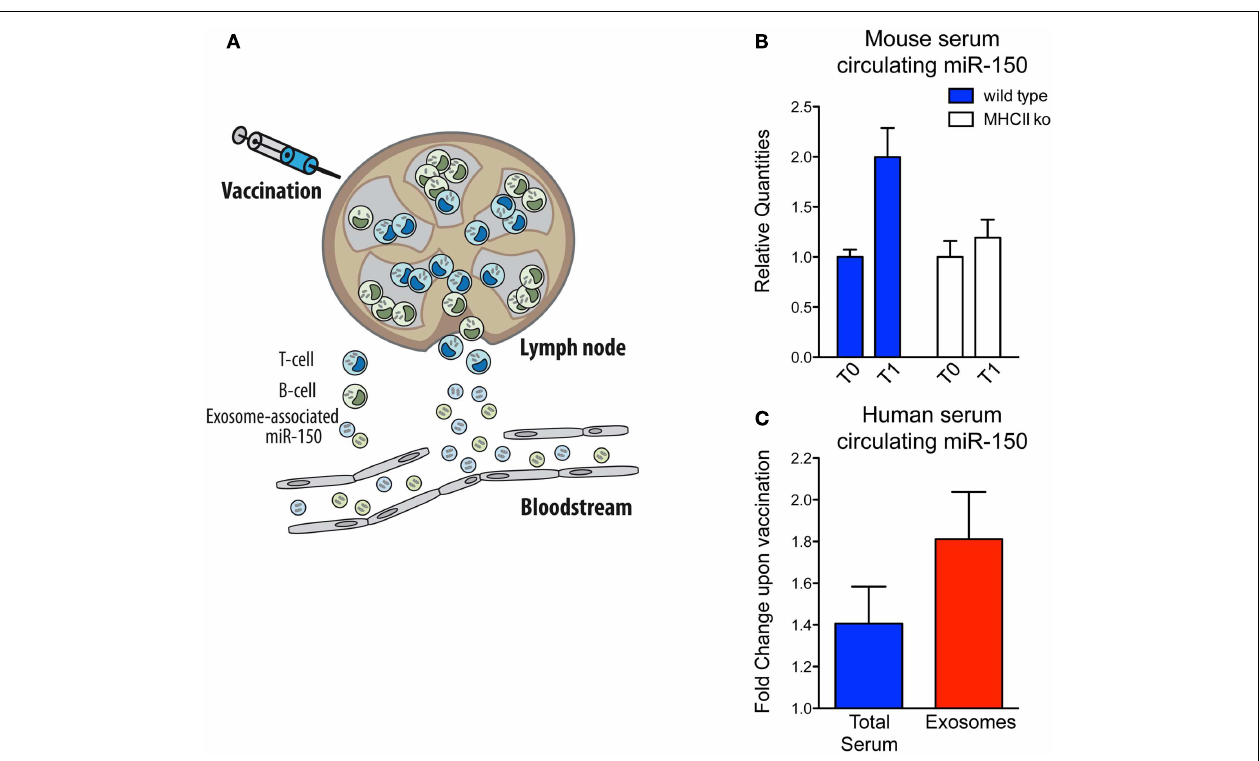
out mice (four animals/group; the result shown is representative of two independent experiments). (C) Human circulating miR-150 increase expressed as fold change upon vaccination in total serum compared to serum purified exosomes (results come from 17 paired samples of sera collected at the time of vaccination and 4weeks after that). Data shown are adapted from previous published studies